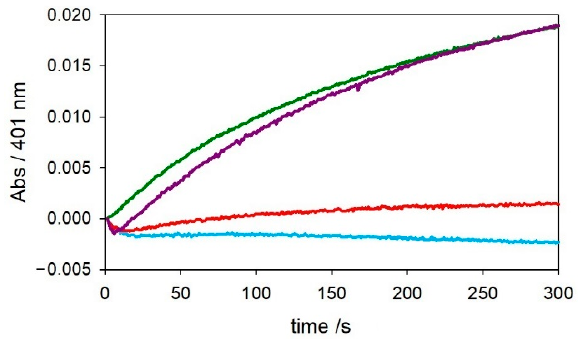
Figure 6. Kinetic profiles of MC (0.3 mM) oxidation with time in 50 mM HEPES buffer at pH 7.4 and 20 °C in the presence of Cu II alone (25 µM, green trace). The same experiments were also performed upon the addition of A β 4–16 complexes: [Cu–A β 4–16 ] at 1:1 molar ratio (25 µM, light blue),